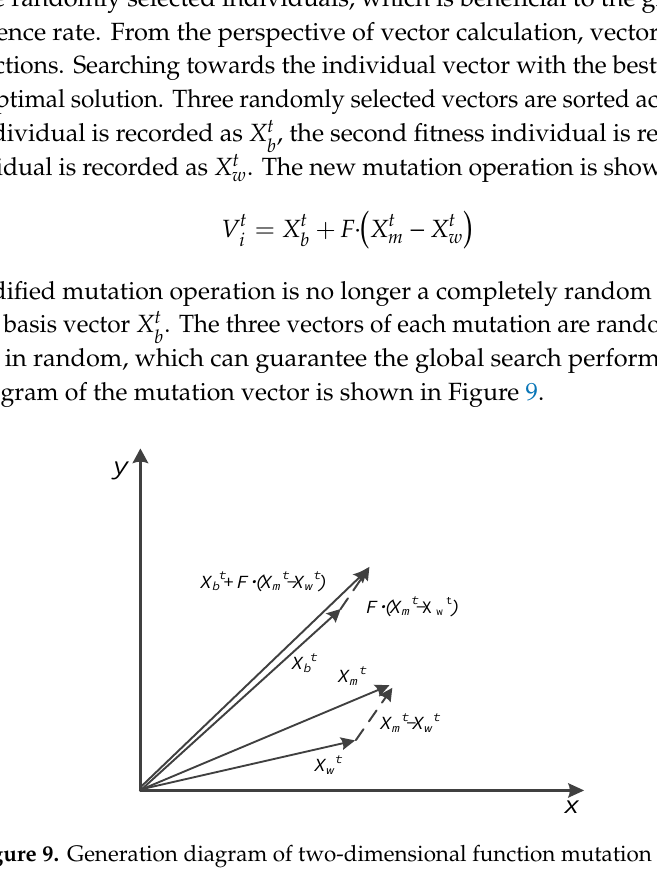
Figure 9. Generation diagram of two-dimensional function mutation vector.